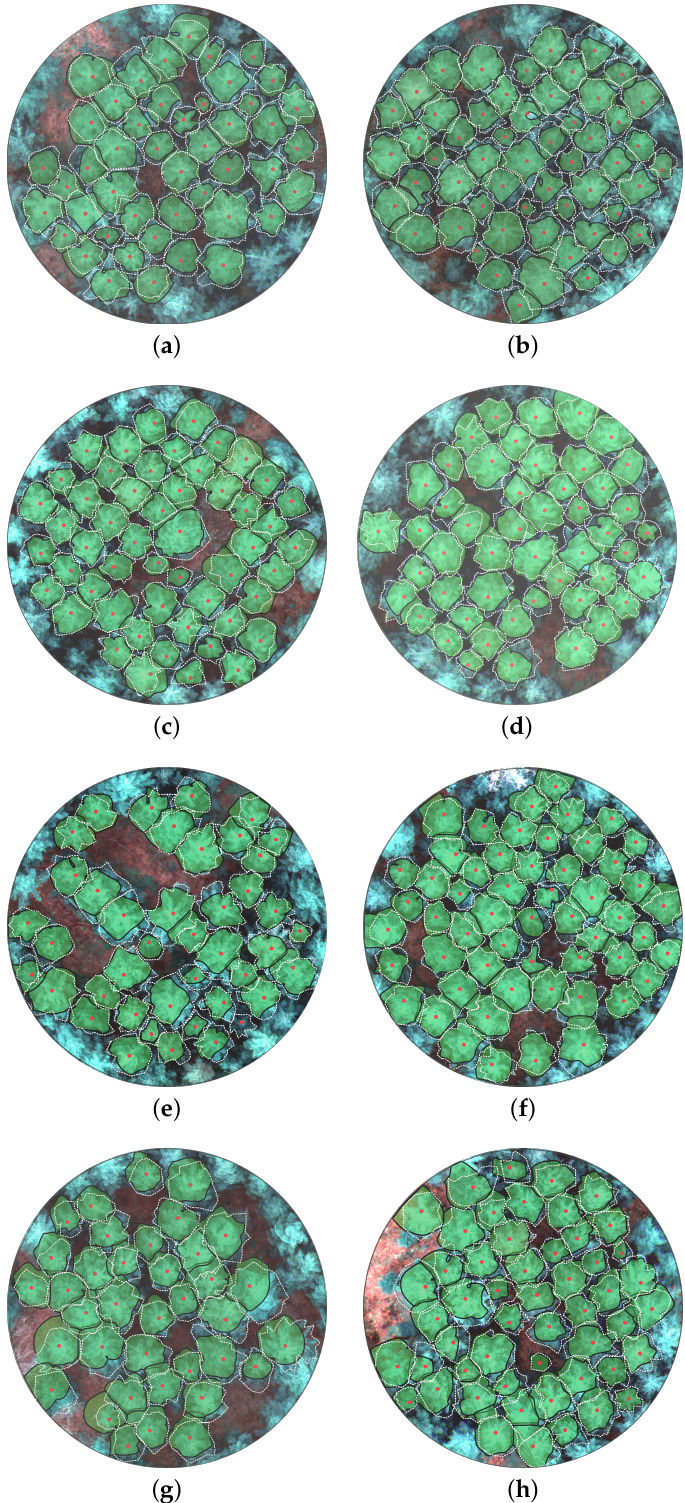
Figure 8. The crown polygons (black lines) were derived using the spectral, spatial-contextual, and structural information-based individual tree crown delineation (S3-ITD) approach for the eight reference plots (Plot 1–Plot 8 ( a – h )). The manually delineated reference crown boundaries and treetops are shown using dotted white lines and red dots,